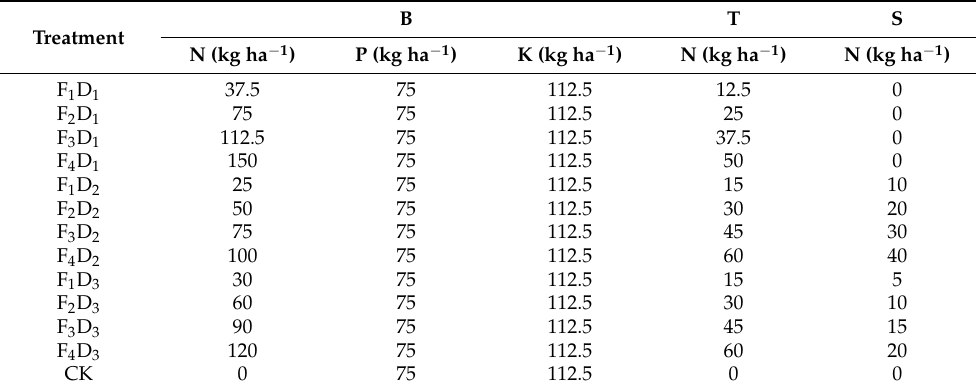
Figure 2. Precipitation and air temperature during the double-harvest rice growing seasons. Table 1. Fertilization treatment of early rice nitrogen fertilizer management